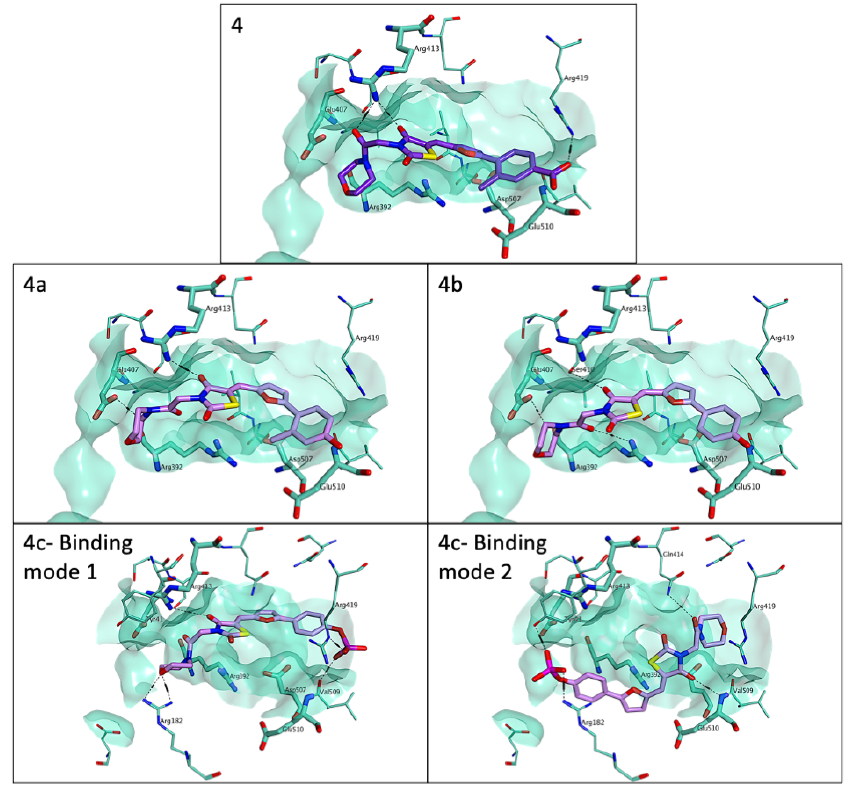
Figure 8. Proposed binding mode for 4 (carbon atoms in purple) and 4a – c (carbon atoms in lilac) to the human norovirus RdRp (PDB ID 4LQ3). The binding site area is represented as green molecular surface. Human norovirus RdRp is represented as green ribbon, with carbon atoms in green. Black dashed lines represent non-bonded interactions (e.g., hydrogen bonds, electrostatic interactions) between the ligand and the amino acid residues of the protein.